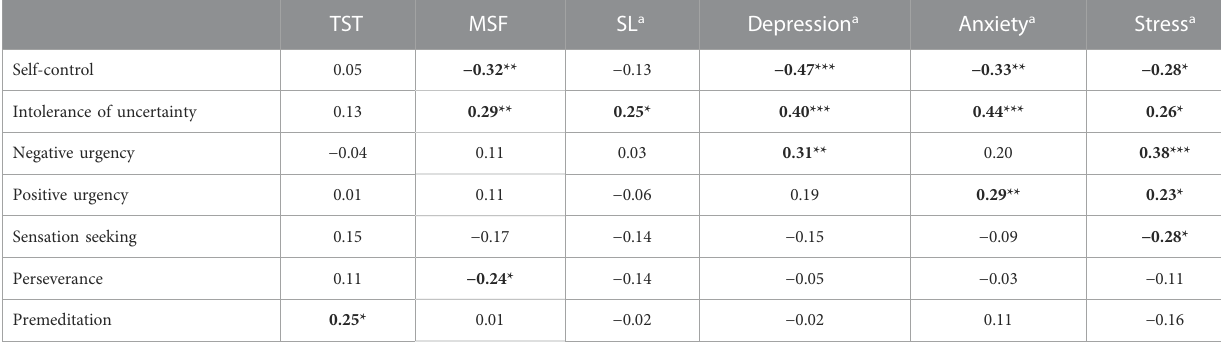
TABLE 4 Correlation matrix between cognitive fi tness, sleep, and mental health. TST MSF SL a Depression a Anxiety a Stress a Self-control